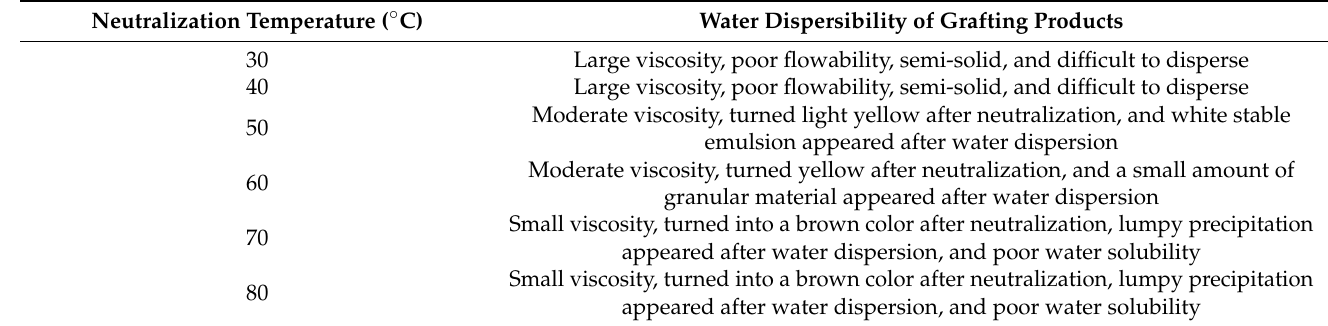
Table 9. Effect of neutralization temperature on the water dispersibility of